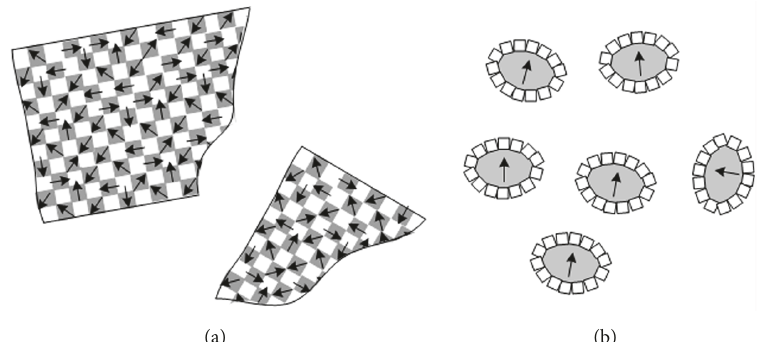
Figure 1: Schematic diagrams of (a) nanocomposite powder prepared by crushing melt-spun ribbon and (b) proposed nanocomposite powder. The white and gray regions indicate the soft and hard magnetic phases, respectively. The arrows indicate the magnetic moment of the hard magnetic